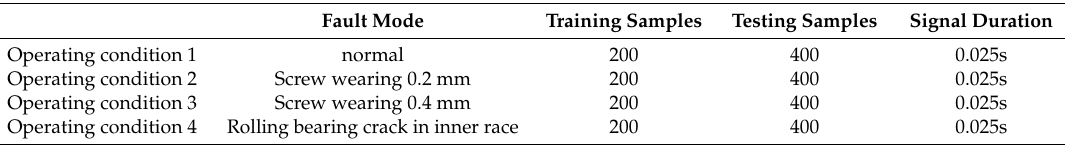
Table 3. Fault modes and sample partition.